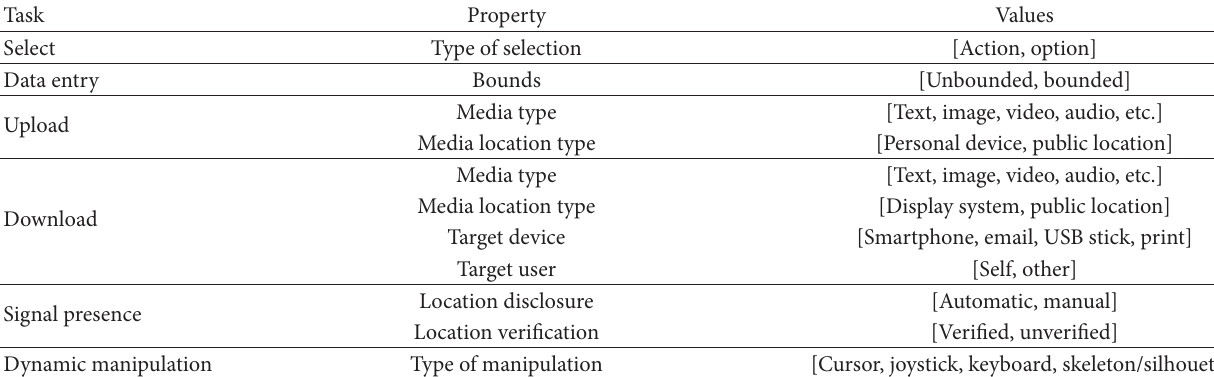
Table 1: Interaction tasks, properties, and